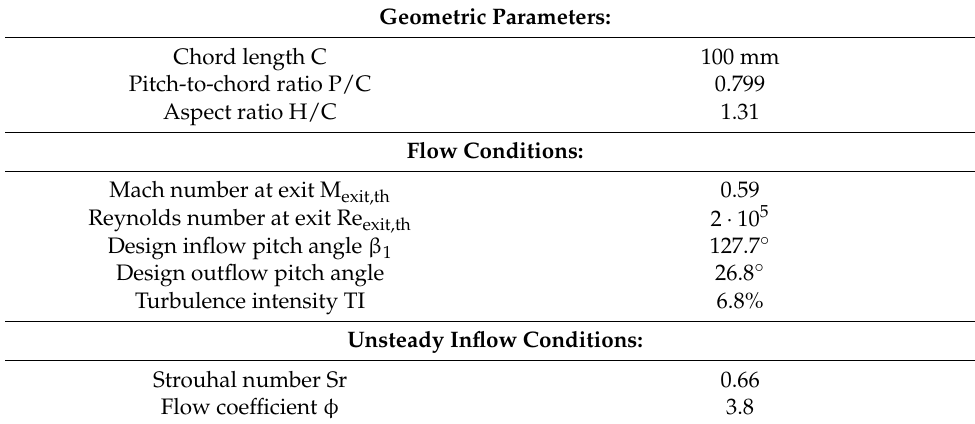
Table 3. T106A linear turbine